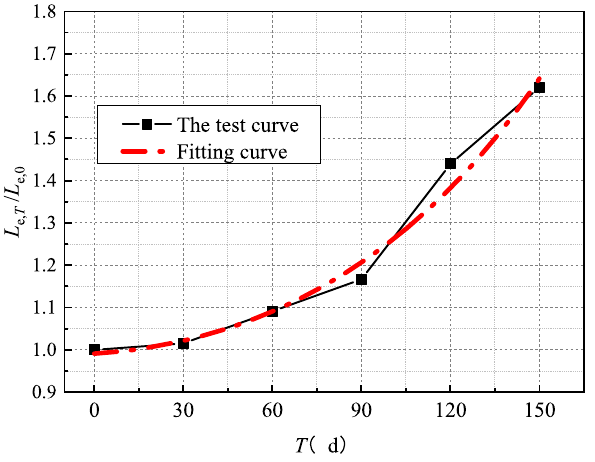
Figure 11. Time-varying curve of effective bond length at the